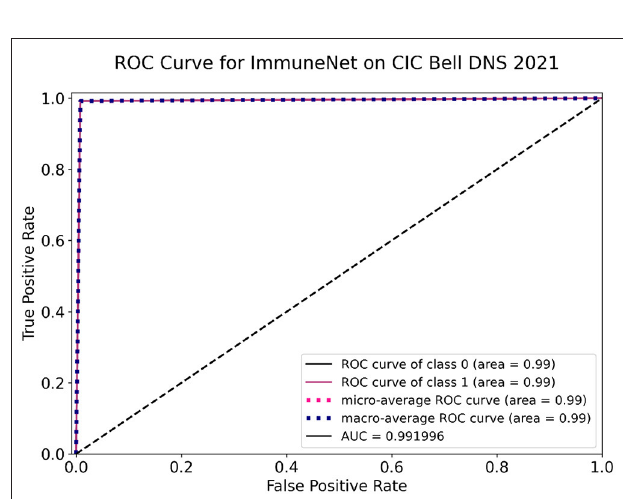
FIGURE 15 | Receiver operating characteristic (ROC) curve of ImmuneNet on CIC Bell DNS 2021